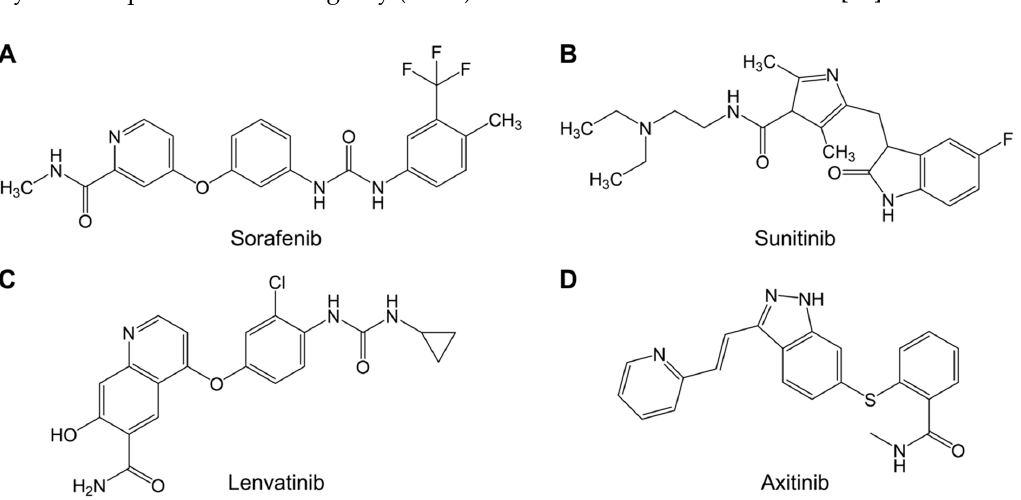
Figure 3. Chemical structures of ( A ) sorafenib (C 21 H 16 ClF 3 N 4 O 2 ), ( B ) sunitinib (C 22 H 23 N 7 O 2 S), ( C